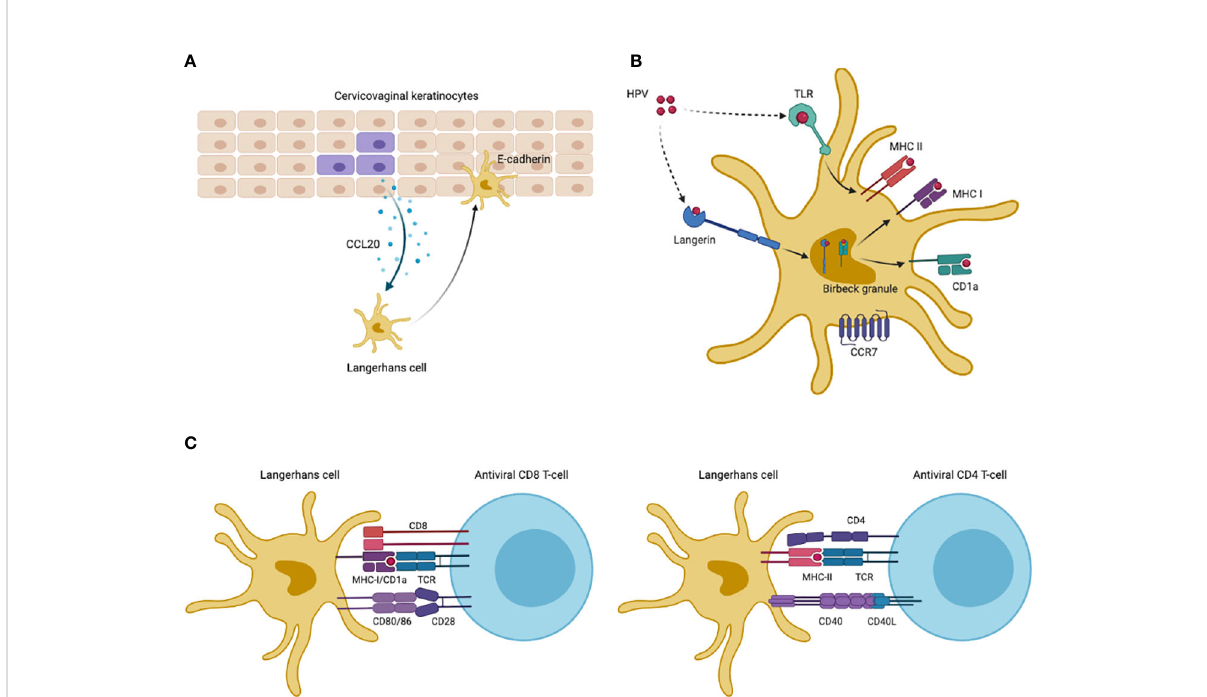
FIGURE 2 HPV antigen uptake and presentation of LCs. (A) Infected keratinocytes increase expression of CCL20 to attract Langerhans cells, which then migrate to in fl ammatory epidermis and adhere to keratinocytes via LCs-derived E-cadherin. (B) LCs maintained in in fl ammatory site capture HPV antigens via TLRs and langerin. Antigen uptake by TLRs are displayed on cell-membrane MHC-II molecules for presentation. Langerin- captured antigens are processed in intracellular Birbeck granules, being loaded on CD1a molecules in Birbeck granules or displayed in MHC-I molecules. CD1a molecules then cycle back to cell surfaces to present antigens. After antigen uptake and processing, LCs are migratory to lymph nodes via CCR7 which are receptors for T cell-derived CCL21. (C) Co-stimulatory molecules promote antigen presentation to CD4+ and CD8+ T cells. This Figureure was created in